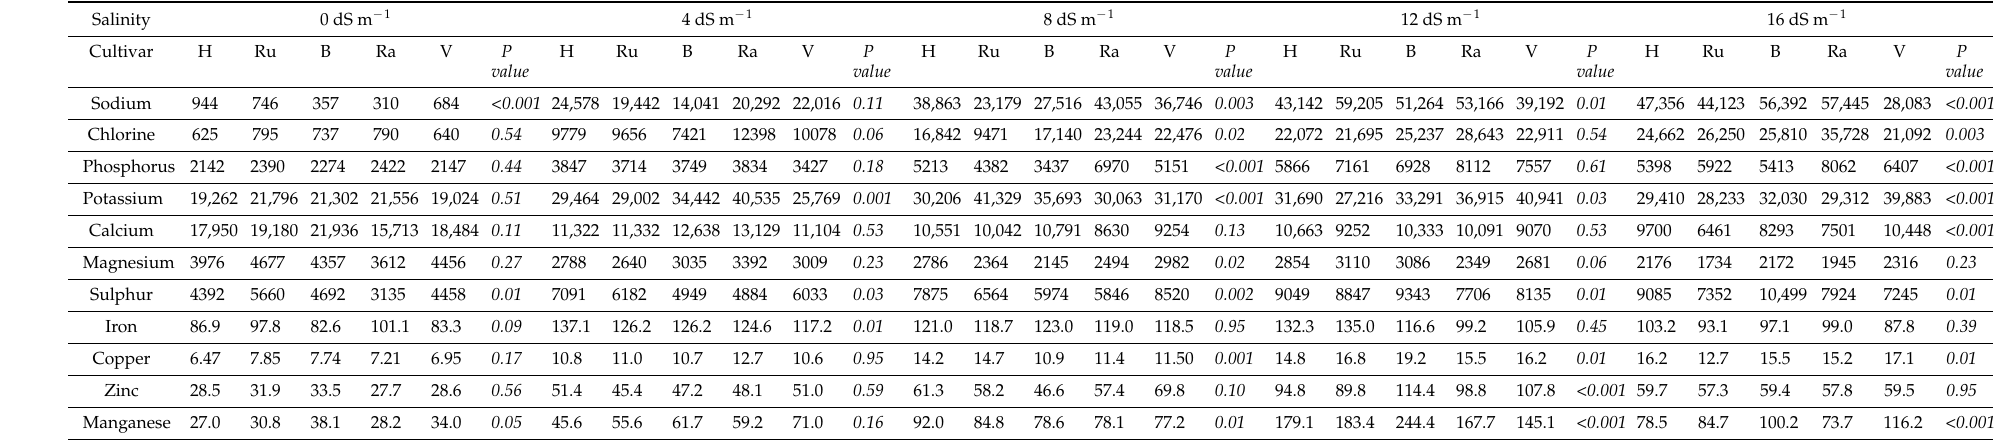
Table 4. Analysis of variance and mean value of elemental concentrations (mg L − 1 ) in leaf tissue of five alfalfa cultivars (H, ‘Halo’; Ru, ‘Rugged’; B, ‘Bridgeview’; Ra, ‘Rangelander’; V, ‘Vernal’) under five gradients of salt stresses (Electrical conductivities of 0 dS m − 1 , 4 dS m − 1 , 8 dS m − 1 , 12 dS m − 1 and 16 dS m − 1 ) as revealed by inductively coupled plasma-mass